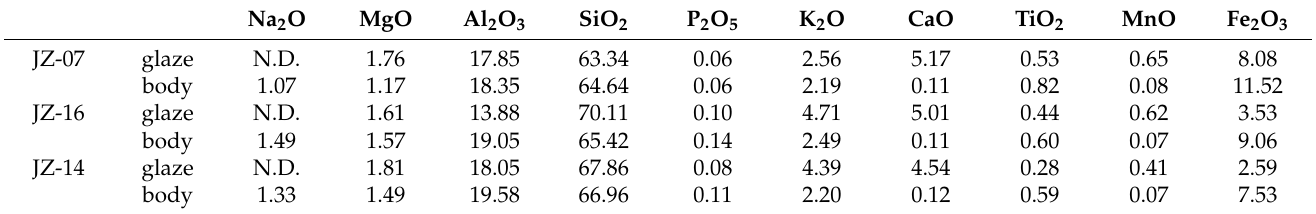
Table 1. Chemical composition data (wt.%) of the glaze and body carried out using PXRF on the three porcelain